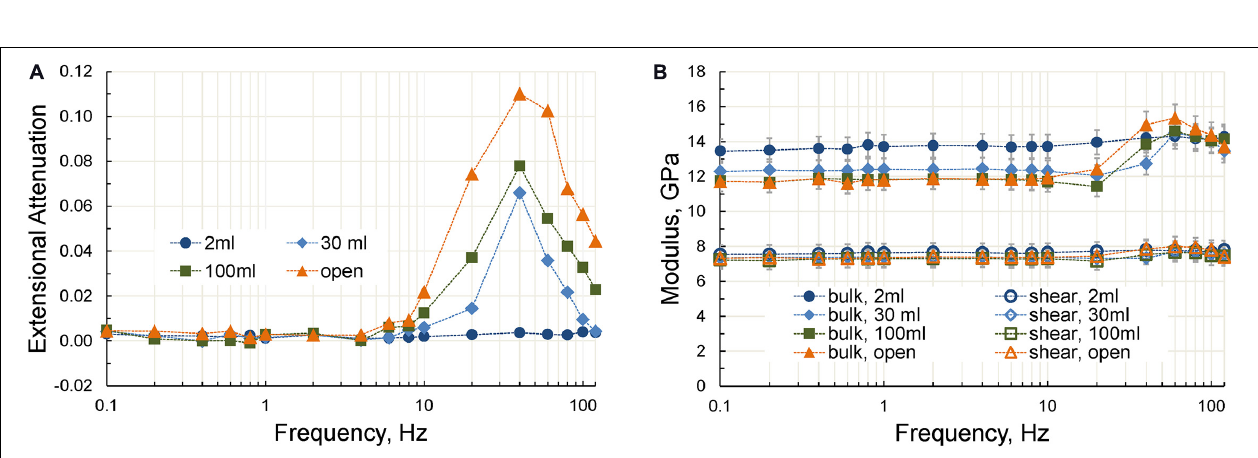
FIGURE 11 | The frequency dependences of the extensional attenuation (A) and the bulk and shear moduli (B) obtained for dead volumes of 2, 30, and 100 ml and for the open fluid line. The measurements are carried out at a differential pressure of 7 MPa.